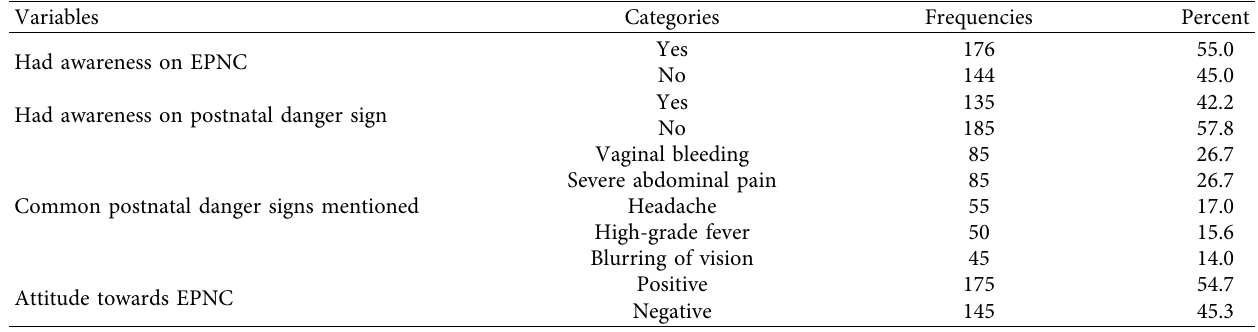
Table 3: Awareness and attitude of the study participants on EPNC services and danger signs after birth in Hawassa Zuria district, Sidama Regional State, Ethiopia,